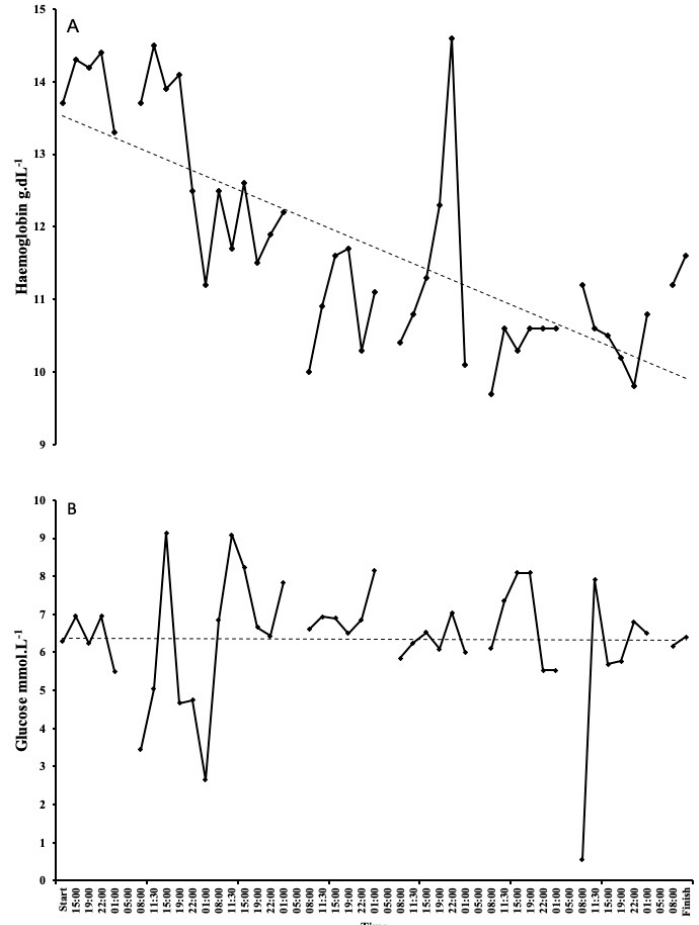
Figure 2. Changes in haemoglobin ( A ) and glucose ( B ) during the world record attempt. Haemoglobin decreased daily, whereas glucose remained remarkably stable. Decreases in glucose were due to periods of gastrointestinal distress, leading to a low intake of food. Please note missing data are from sleep periods 1–5 a.m.